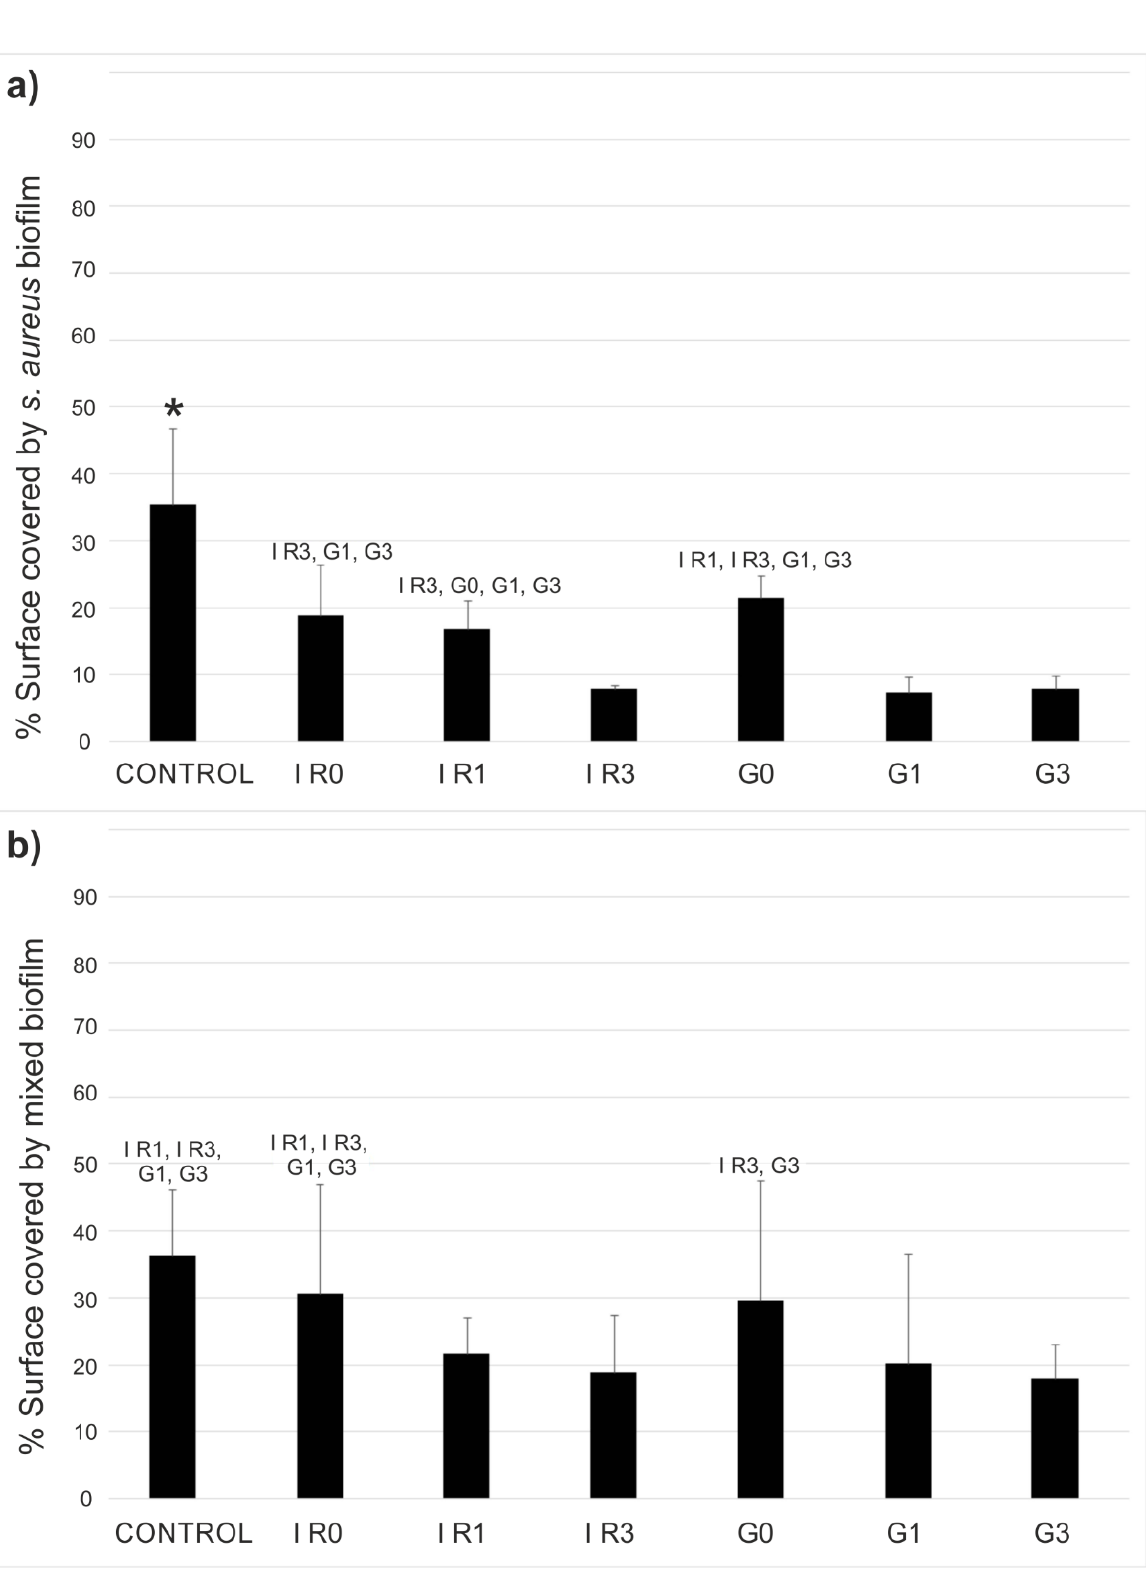
Figure 11. Biofilm inhibition test. Results are given in mean percentage of titanium surface covered with ( a ) S. aureus or ( b ) mixed oral bacteria after 48 h of incubation. Control sample is the bare titanium disc without Ag-NPs. The other samples correspond to Ti discs with immobilized Ag-NPs obtained according to conditions of Table 3. The error bars represent the standard deviation (* p < 0.05 with respect all the other materials).